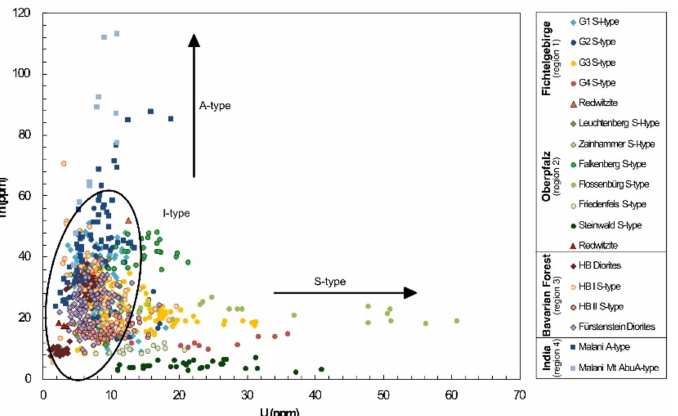
Figure 7. Th versus U concentrations for all samples. Th and U concentrations show a large range, even within individual regions. However, A-type granites tend to have higher Th concentrations, I-type granites have moderate concentrations (marked with the ellipse) and S-type granites tend to have higher U concentrations. Abbreviations: FG: Fichtelgebirge (Region 1), OPf: Oberpfalz (Region 2), BF: Bavarian Forest (Region 3), HB: Hauzenberg, MIS: Malani Igneous Suite, gamma-ray data from in situ measurements of gamma radiation [75]; MIS A-type geochemical data: U and Th values from geochemical analyses from the Mt. Abu batholith [79,86].